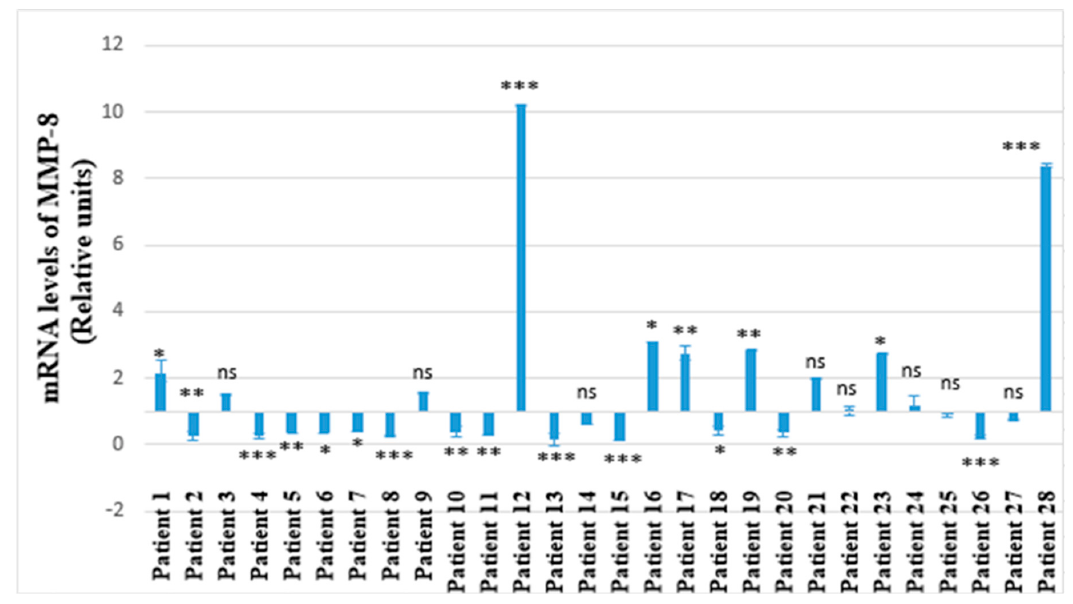
Figure 2. MMP-8 mRNA levels in saliva of 28 children with diagnosed pyelonephritis. Expression levels are presented in relative units ± SEM versus human β -actin as endogenous control. * p < 0.05 versus control group; ** p < 0.01 versus control group; *** p < 0.001 versus control group; ns—not significant.